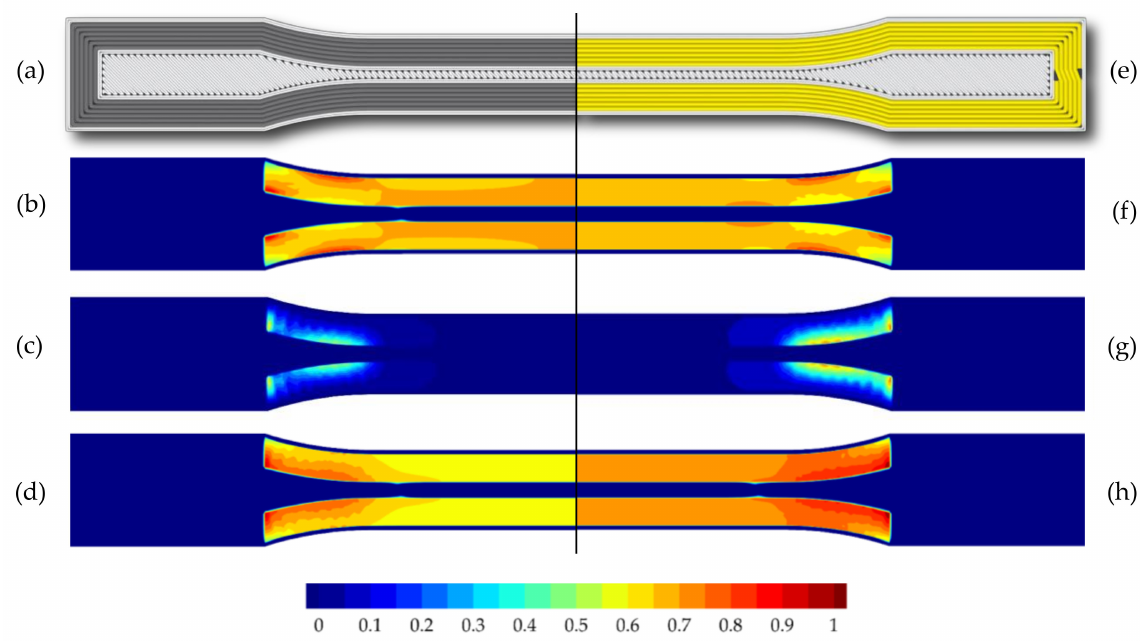
Figure 13. Comparison between damage predictions for hybrid tensile specimen (50 CF /50 GF ): ( a ) vi- sualization of G-code, ( b ) Hashin damage criterion–fiber tension F t matrix tension F t m , and ( d ) Tsai–Wu criterion; Hashin and Tsai–Wu damage criterion, respectively, when reaching a value of ≥ 1.